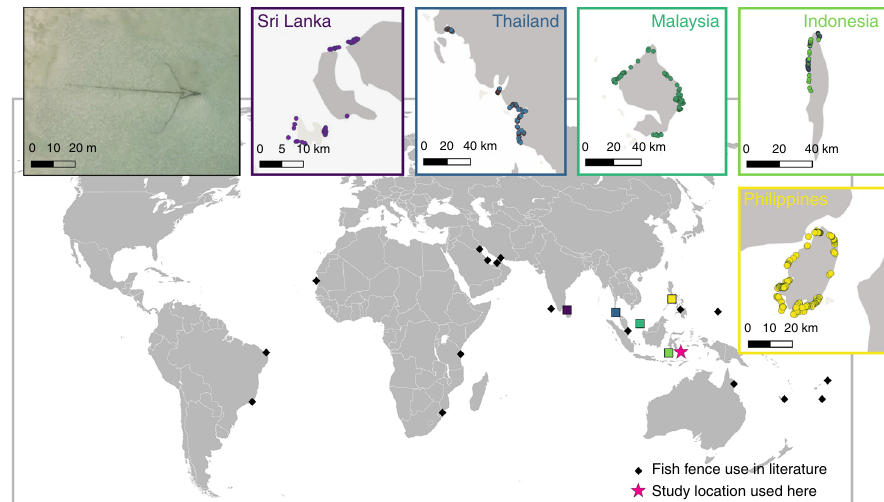
Fig. 2 Global distribution of artisanal fi sh fence use, showing the location of mentions in the literature (black diamonds), Google Earth visual surveys showing intensive use of fi sh fences (inset maps corresponding by colour to squares on main map), study site location used for this study in Wakatobi National Park, Indonesia (pink star), and an example fi sh fence viewed via Google Earth (inset photo). Where literature mentions describe regional studies with ranges of hundreds of kilometres, symbols denote the approximate centre point of those studies. Map data are from